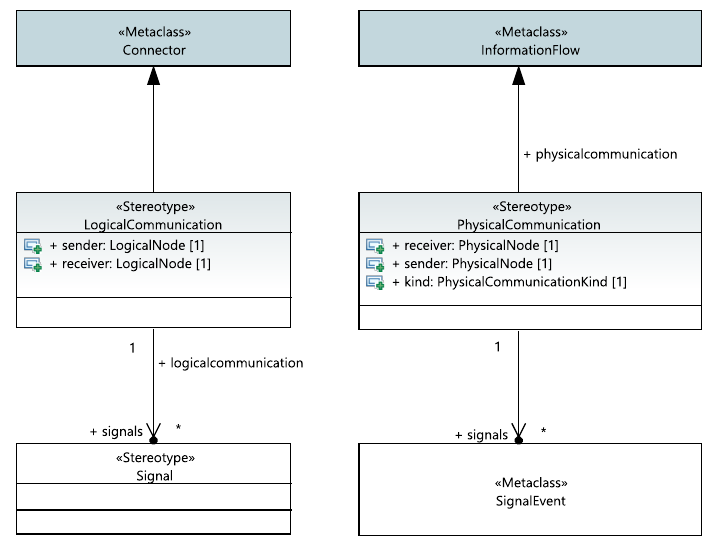
Figure 8. Meta-model of logical and physical communications.